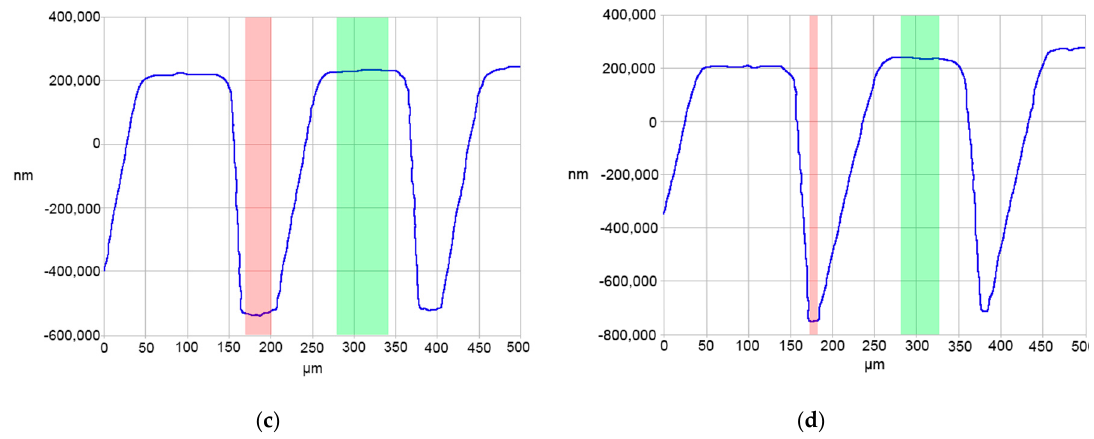
Figure 11. Contact profilometry traces for ( a ) part 45 from Group A, ( b ) part 30 from Group B, ( c ) part 25 from Group C, and ( d ) part 5 from Group D microfeatures molded from Tool 4.